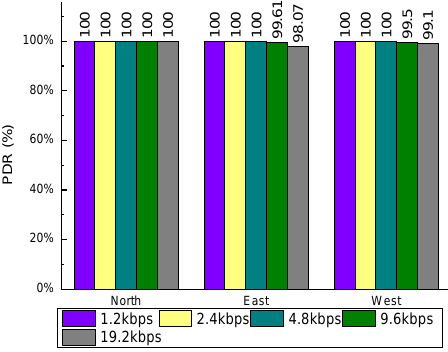
Sensors 2020 , 20 , x FOR PEER REVIEW Figure 13. Relationship between PDR and payload length in the same floor. Figure 13. Relationship between PDR and payload length in the same floor. Figure 13. Relationship between PDR and payload length in the same floor.